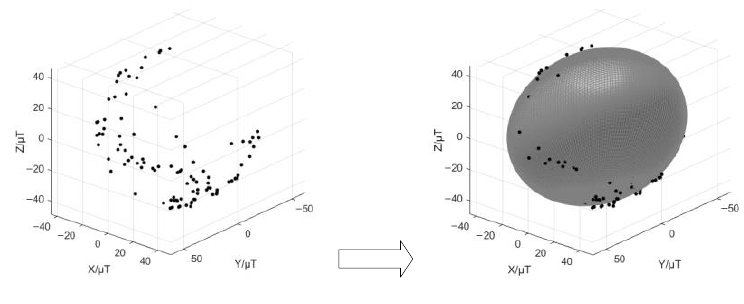
Figure 5. The preprocessing of raw measuring magnetic data.